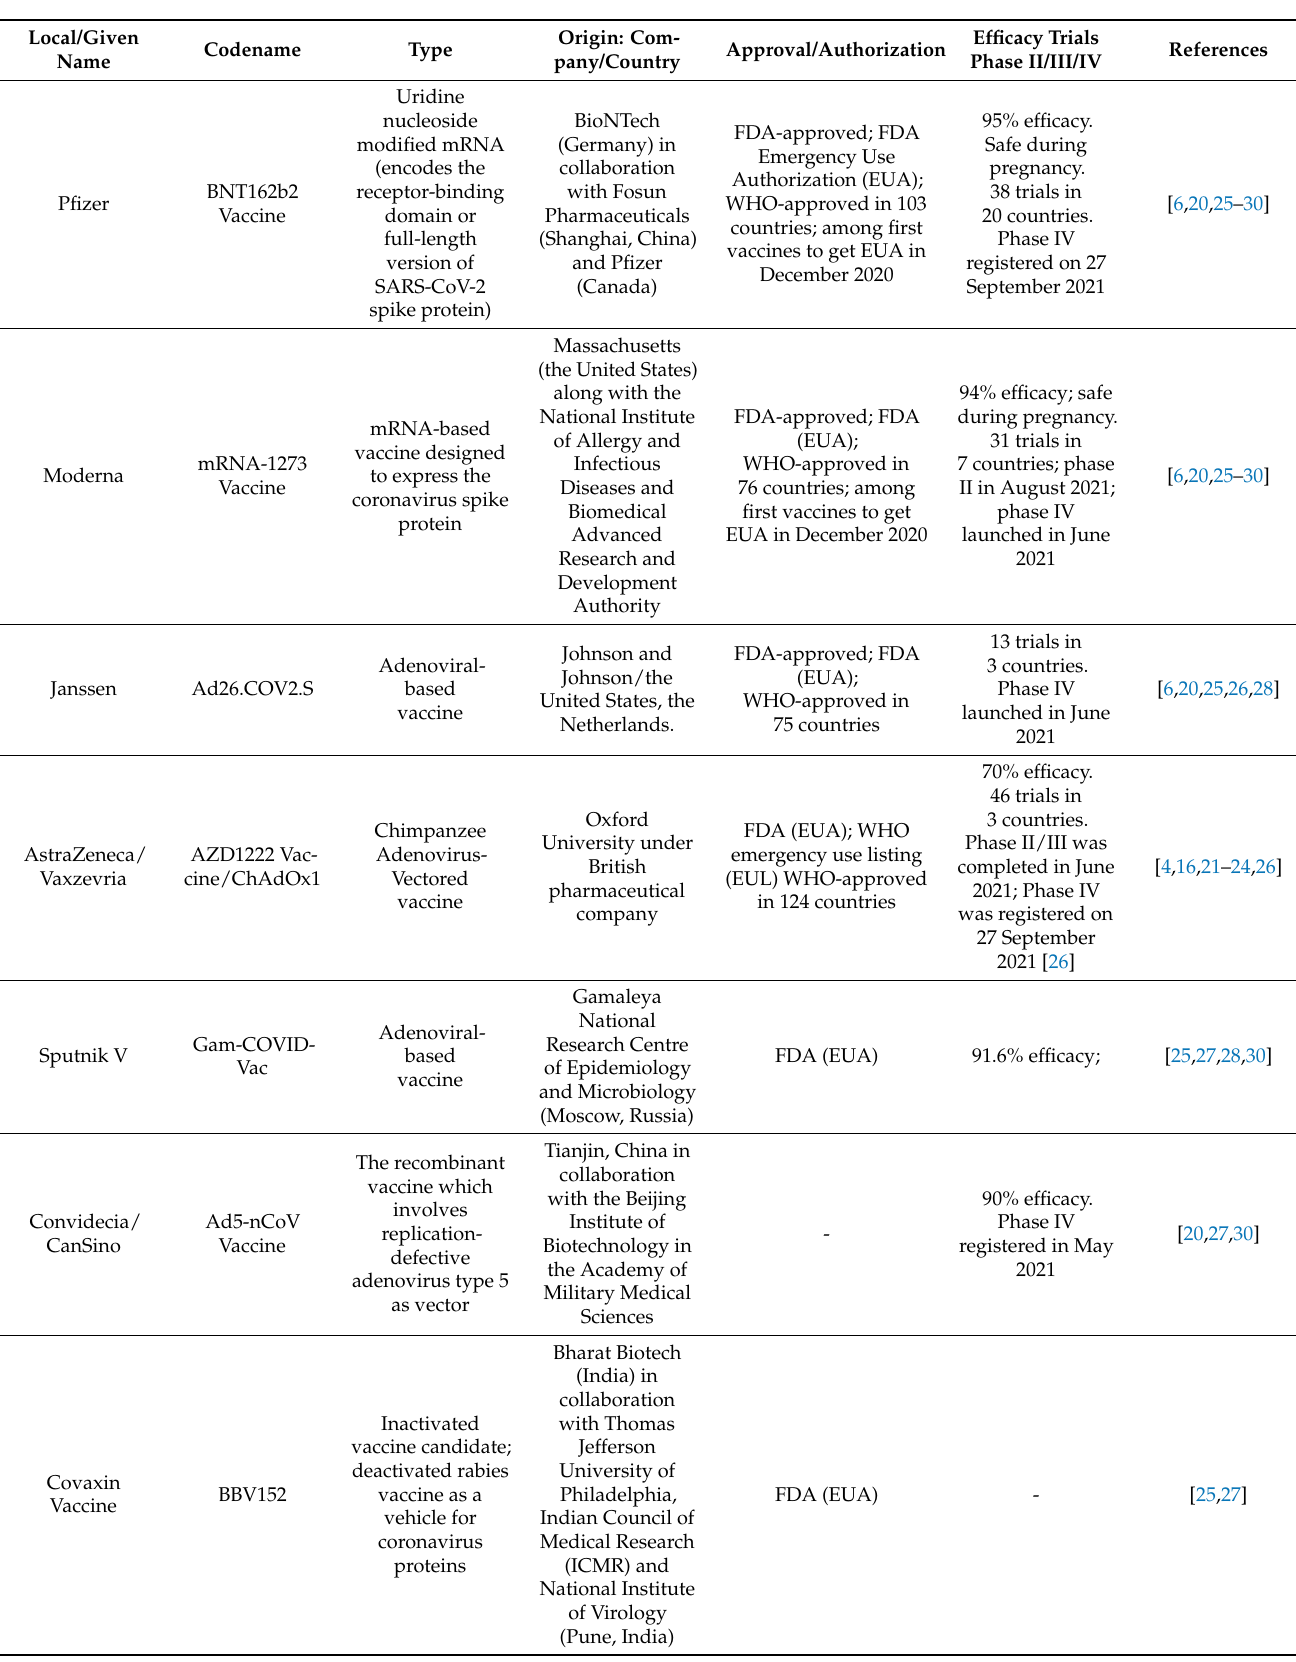
Table 1. Most-utilized vaccinations against